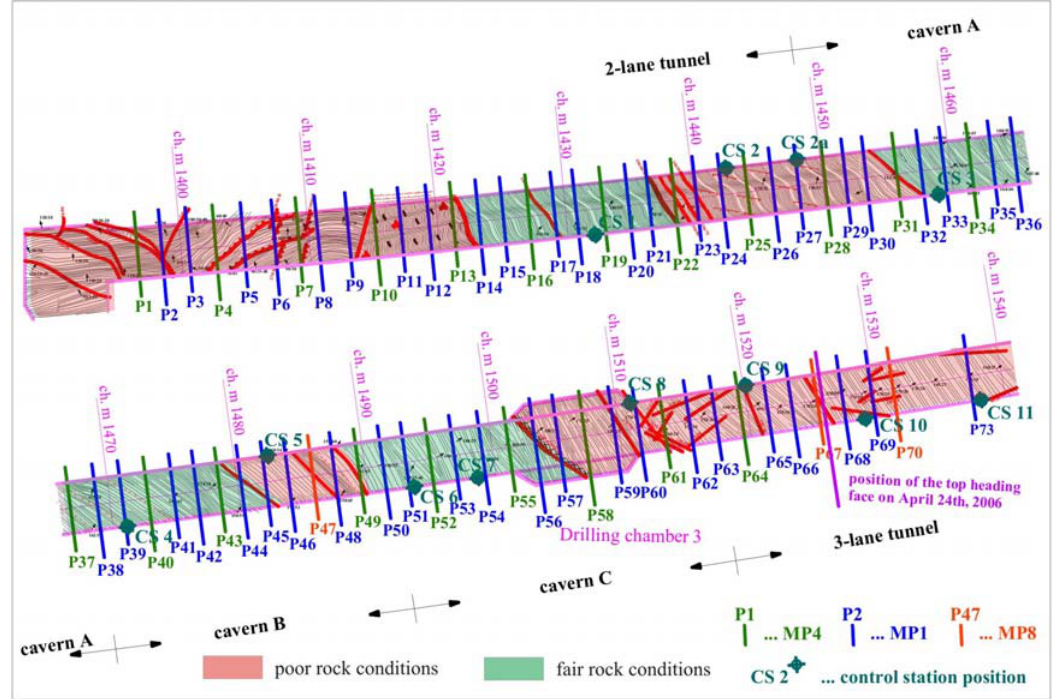
Figure 8. Disposition of the measuring cross sections and control station positions in the left tube of the exploratory tunnel with lined geological